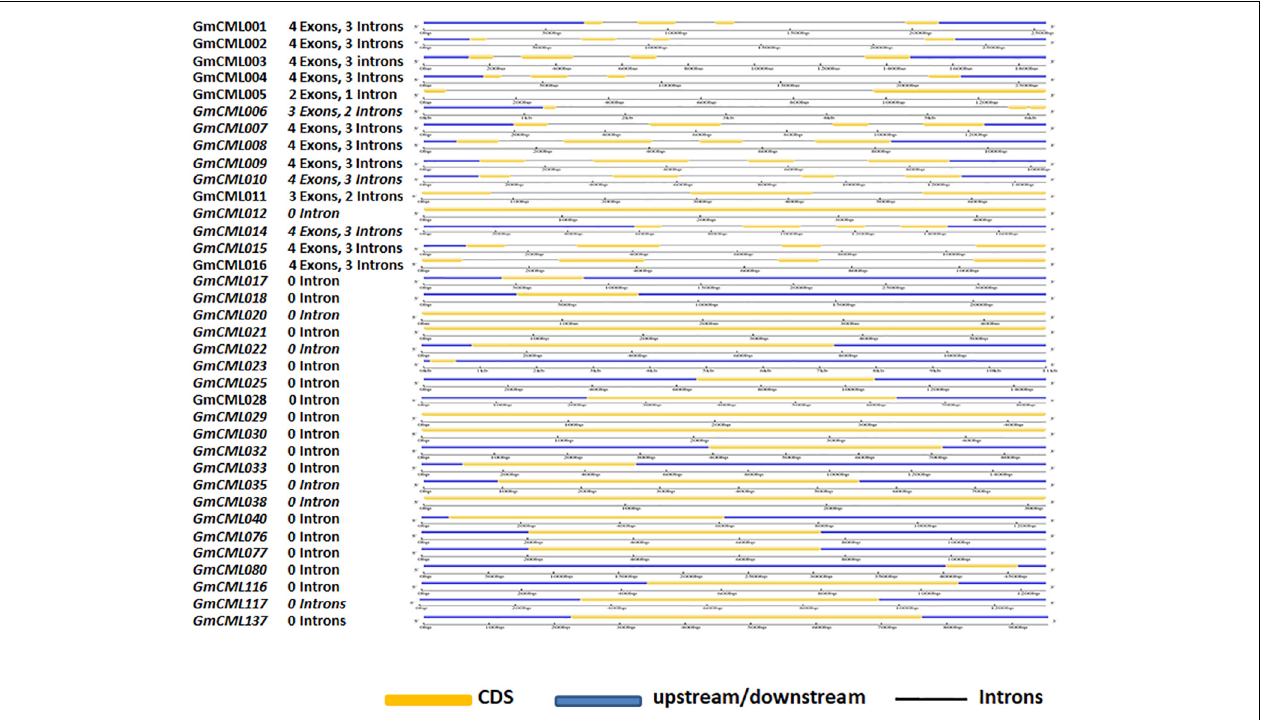
FIGURE 4 | The gene structure analysis of GmCML s. The gene structure analysis showing the distribution of exon-intron in GmCMLs . The exons, upstream/downstream, and introns are represented by yellow, blue, and black colors, respectively. The exon-intron distribution analysis was examined using Gene Structure Display server